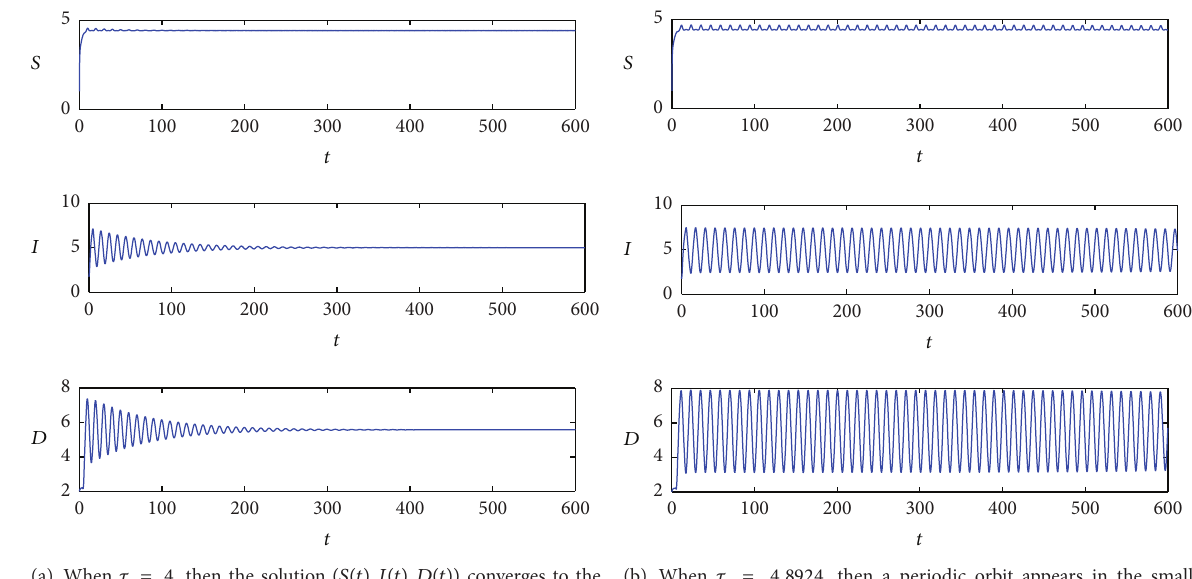
(b) When 𝜏 = 4.8924 , then a periodic orbit appears in the small neighborhood of the endemic equilibrium 𝐸 ∗ = (4.4138,5.0136,5.726)